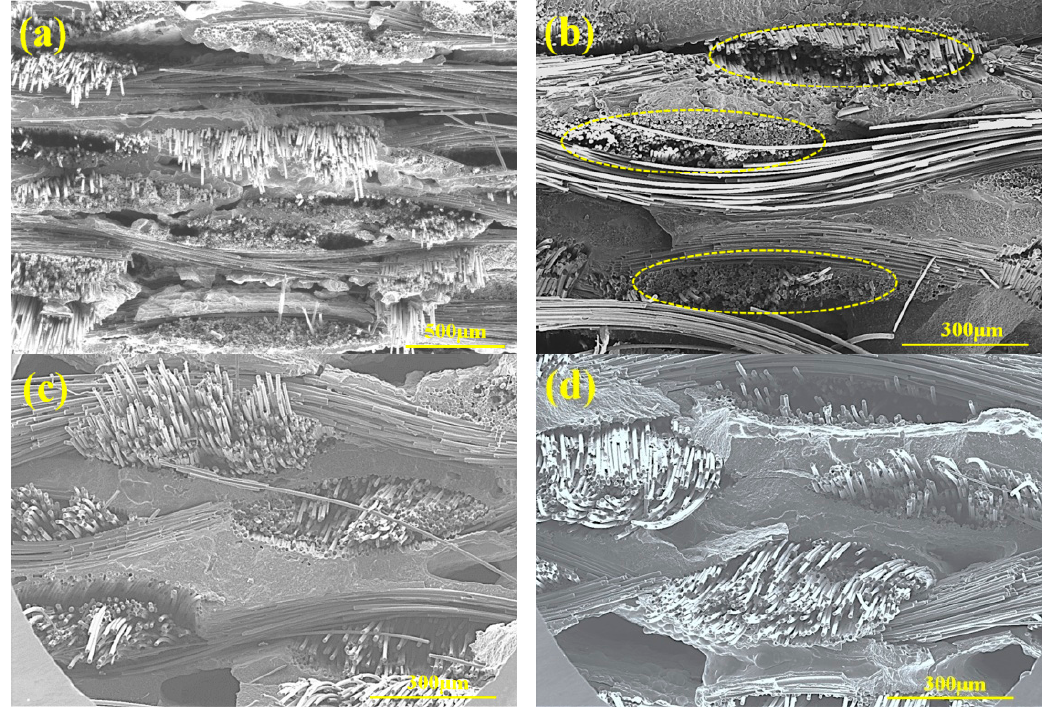
Figure 6. Fracture surface of ( a ) SiC/SiC after oxidation at 800 °C and SiC/SiC-SiBC after oxidation at ( b ) 800, ( c ) 1000, and ( d ) 1200 °C.